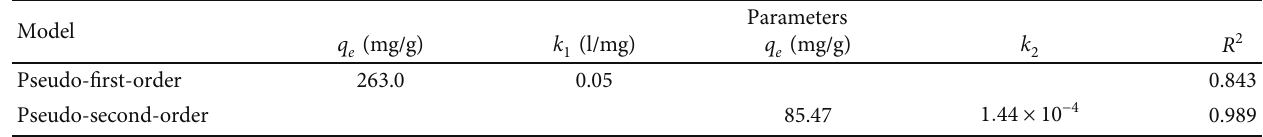
Table 2: Kinetic parameters for methylene blue adsorption onto CPCN composite fi